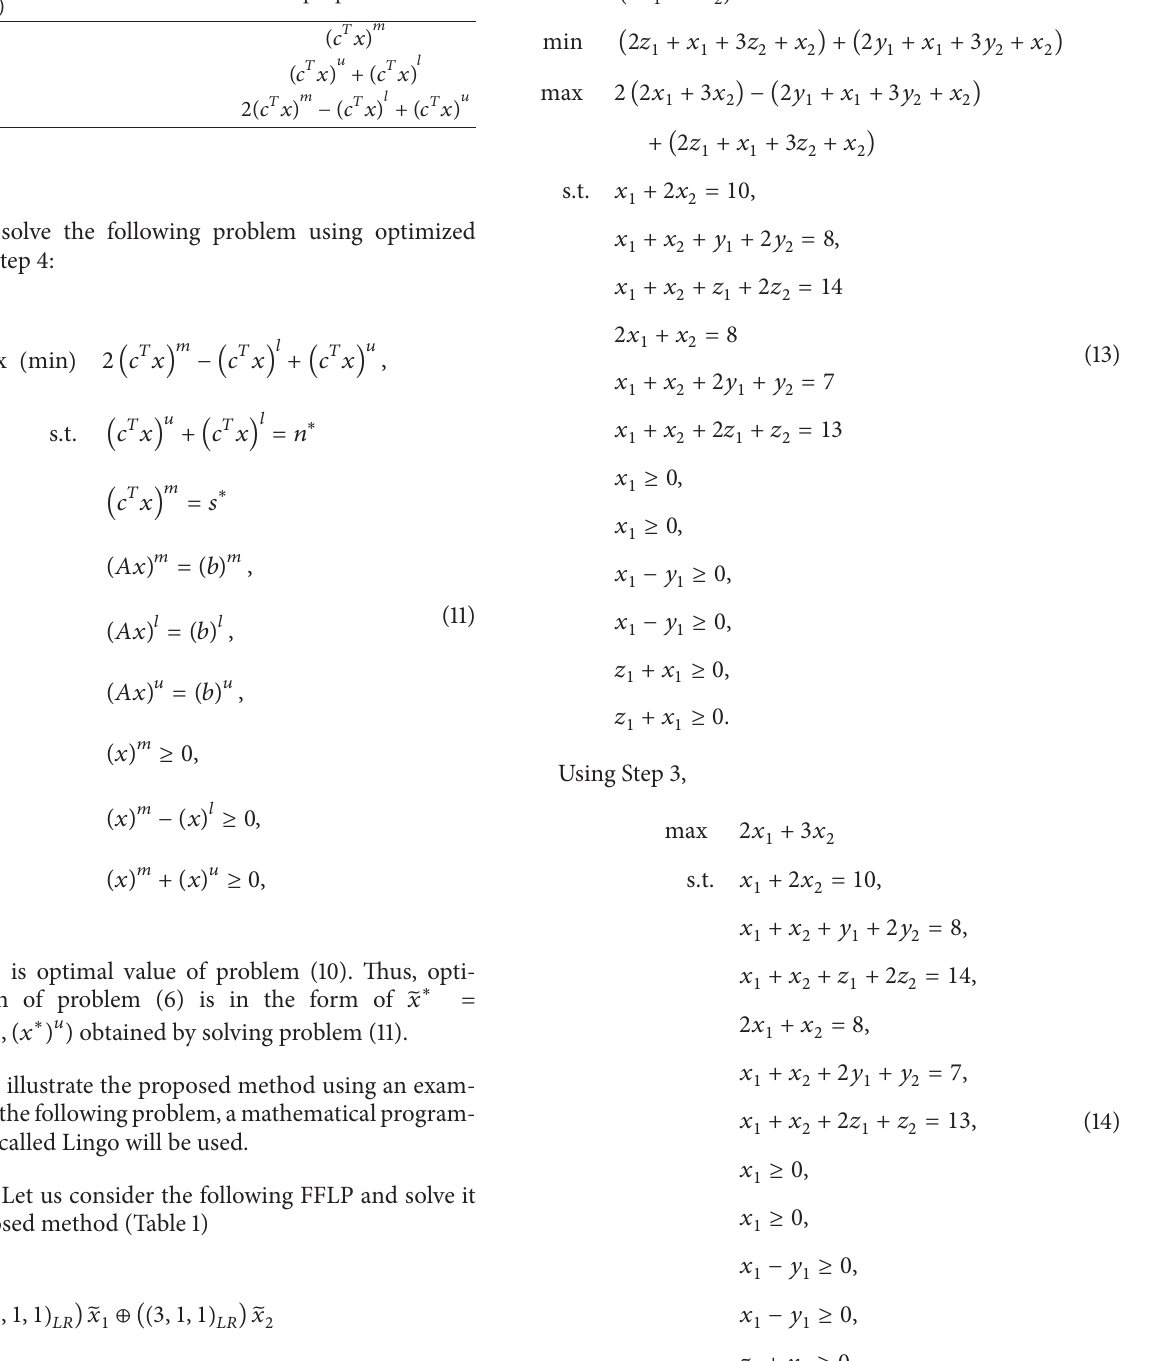
Table 1: The solution of Example 11 by the proposed method. Proposed